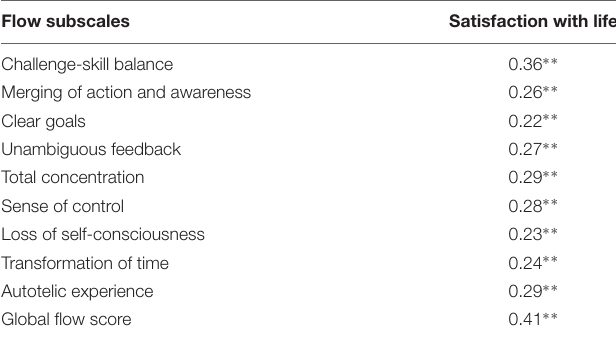
TABLE 6 | Pearson correlation coefficients between flow dimensions and satisfaction with life. Flow subscales Satisfaction with life